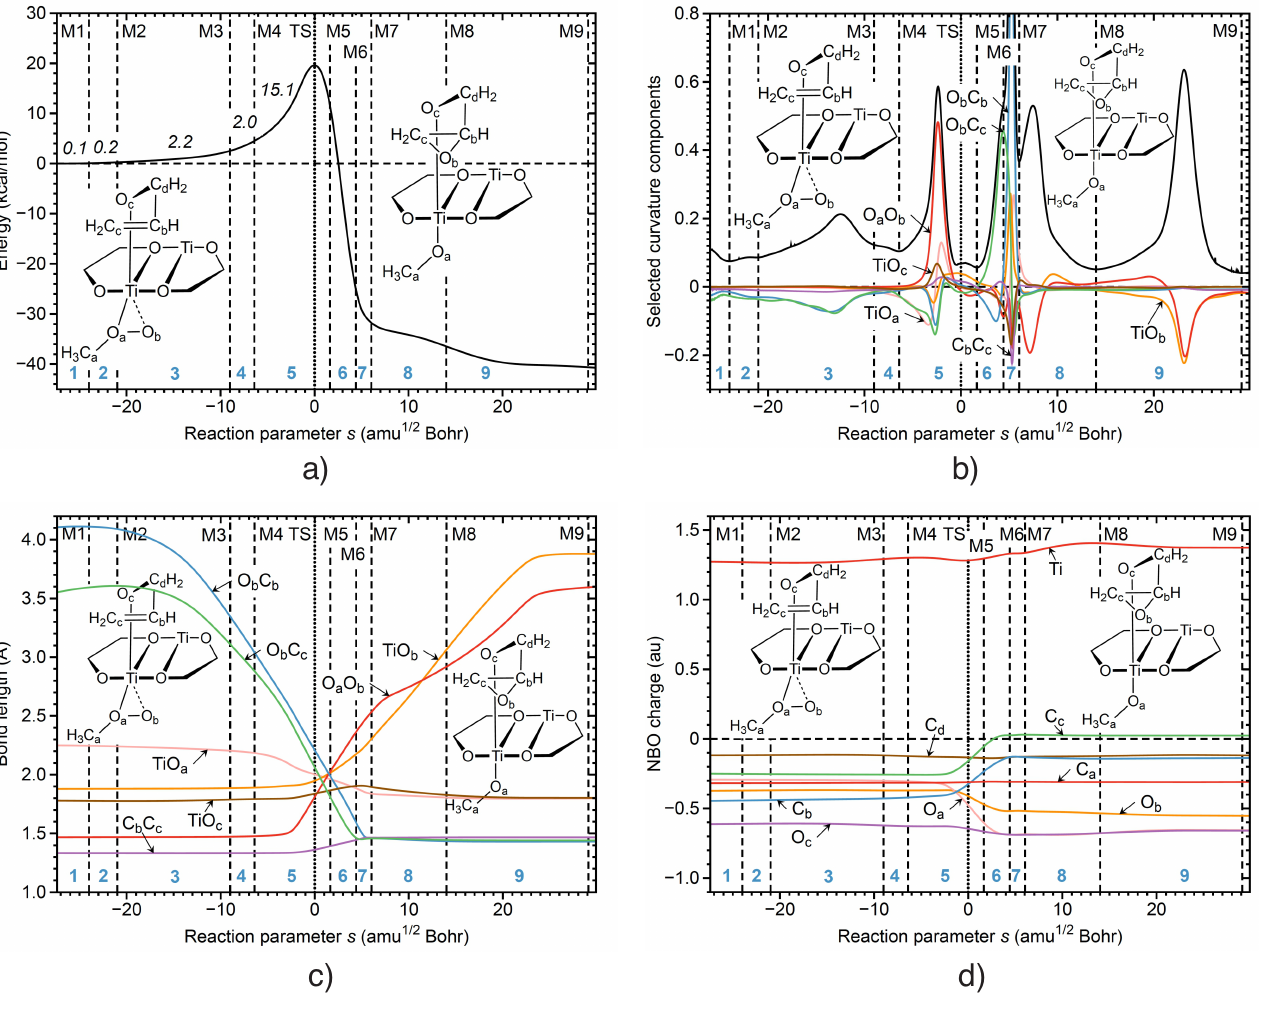
Figure 6. Properties of reaction R3 along the reaction path. ( a ) The energy profile, where the energy contributions of each reaction phase to the activation energy are indicated by italic numbers. ( b ) Decomposition of the reaction curvature into selected chemical bonds. ( c ) The change of the selected bond lengths. ( d ) The change of the selected NBO atomic charges. The curvature minima are shown as broken vertical lines and are labeled as M1, M2 and so on. The position of TS is indicated as a dotted line. The reaction phases are indicated by blue numbers. B3LYP/6-31G(d,p)/SDD(Ti) level of